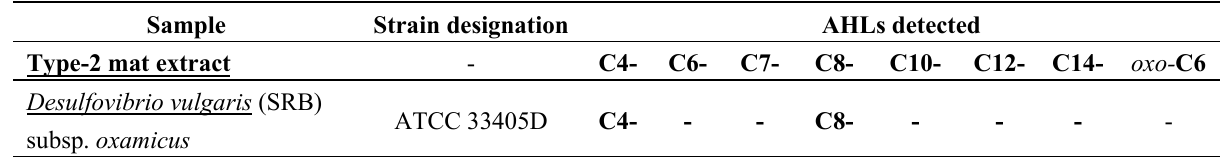
Table 2. Summary table showing acylhomoserine lactones (AHL) extracted from the Type-2 surface mats of marine stromatolites, and from two stromatolite isolates of sulfate-reducing bacteria (SRB). AHLs were identified using mass-spectrometry, and are designated as C4-, C6-, C8-, etc ., based on the number of carbons in the acyl chain. An oxo -C6-AHL indicates a C6-AHL having an oxo -group at the C3-position. (* same strain used in